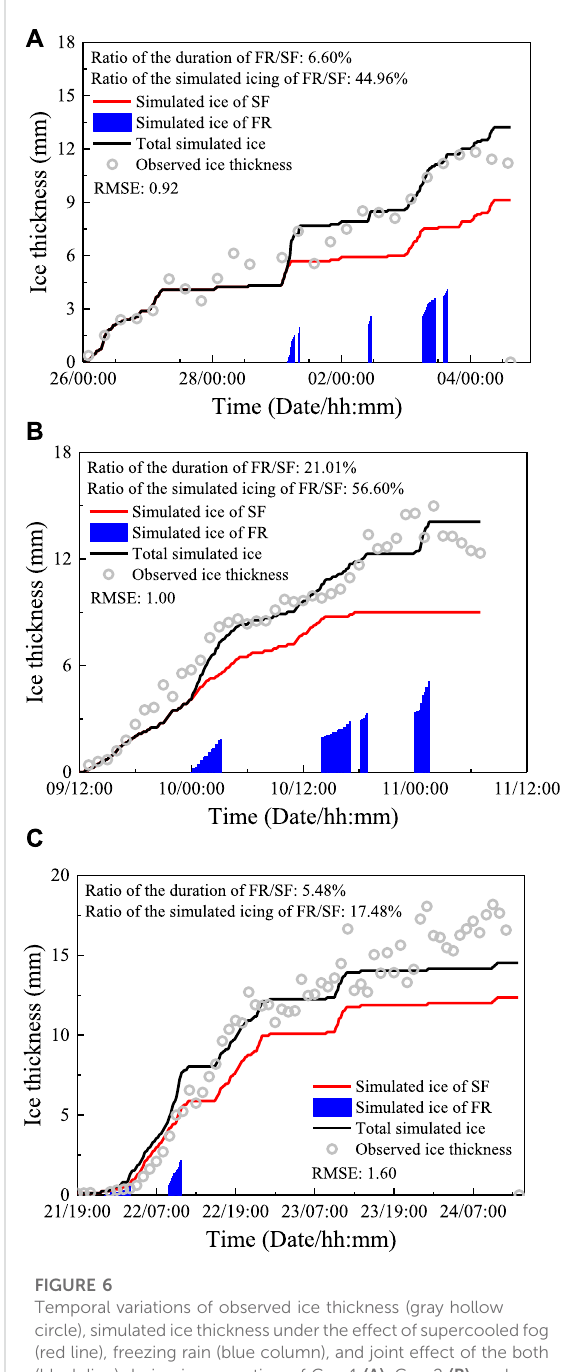
FIGURE 6 Temporal variations of observed ice thickness (gray hollow circle),simulatedicethicknessundertheeffectofsupercooledfog (red line), freezing rain (blue column), and joint effect of the both (black line) during ice accretion of Case1 (A) , Case2 (B) , and Case3 (C) in Hubei Province in winter of 2008 and